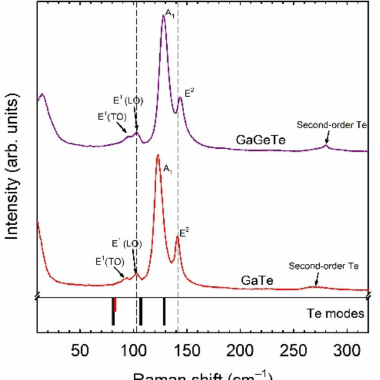
Figure 7. Comparison of the unpolarized Raman spectrum of Te and the unpolarized anomalous Raman spectra of layered GaTe and GaGeTe. E modes of Te show a superindex in order of increasing frequency. The bottom black tick marks show the calculated Raman-active TO modes of trigonal Te (E 1 , A 1 , and E 2 ). The bottom red tick marks show the calculated IR-active A 2 (TO) mode of trigonal Te. Please note that the E 1 and E 2 modes of Te are also IR-active, so the A 2 , E 1 , and E 2 modes can also show LO features that are difficult to observe in pure Te. The spectra have been normalized and vertically shifted for the sake of comparison and